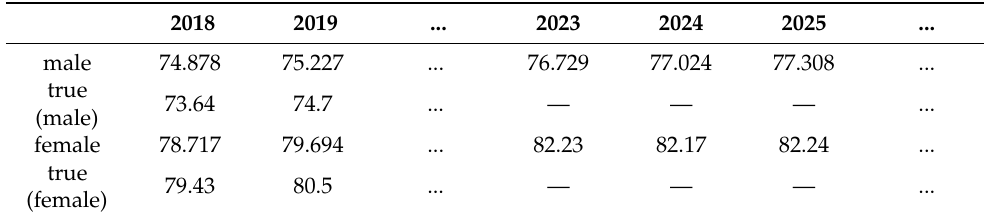
Table 4. Life expectancy on